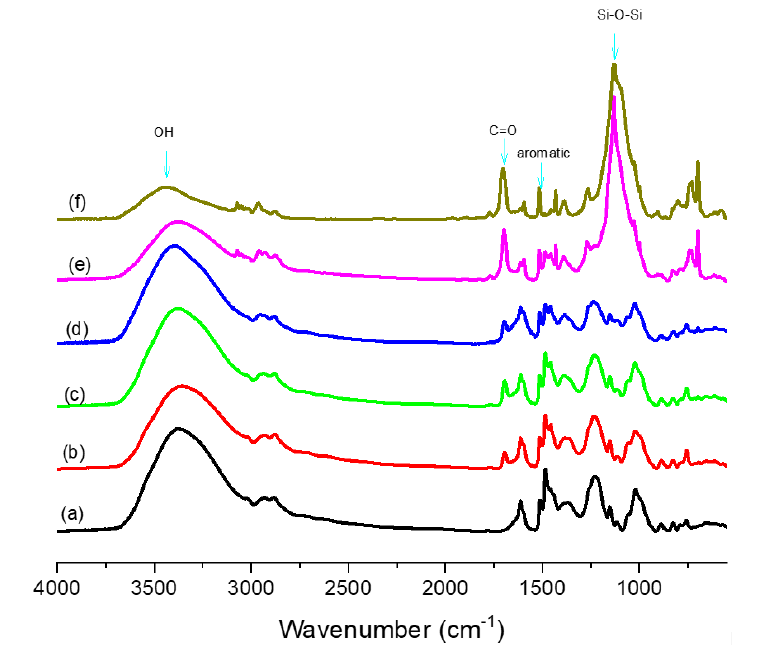
Figure 4. FTIR spectra of ( a ) pure phenolic, ( b ) PDDSQ-30, ( c ) PDDSQ-45, ( d ) PDDSQ-50, ( e ) PDDSQ-80, and ( f ) pure PDDSQ.